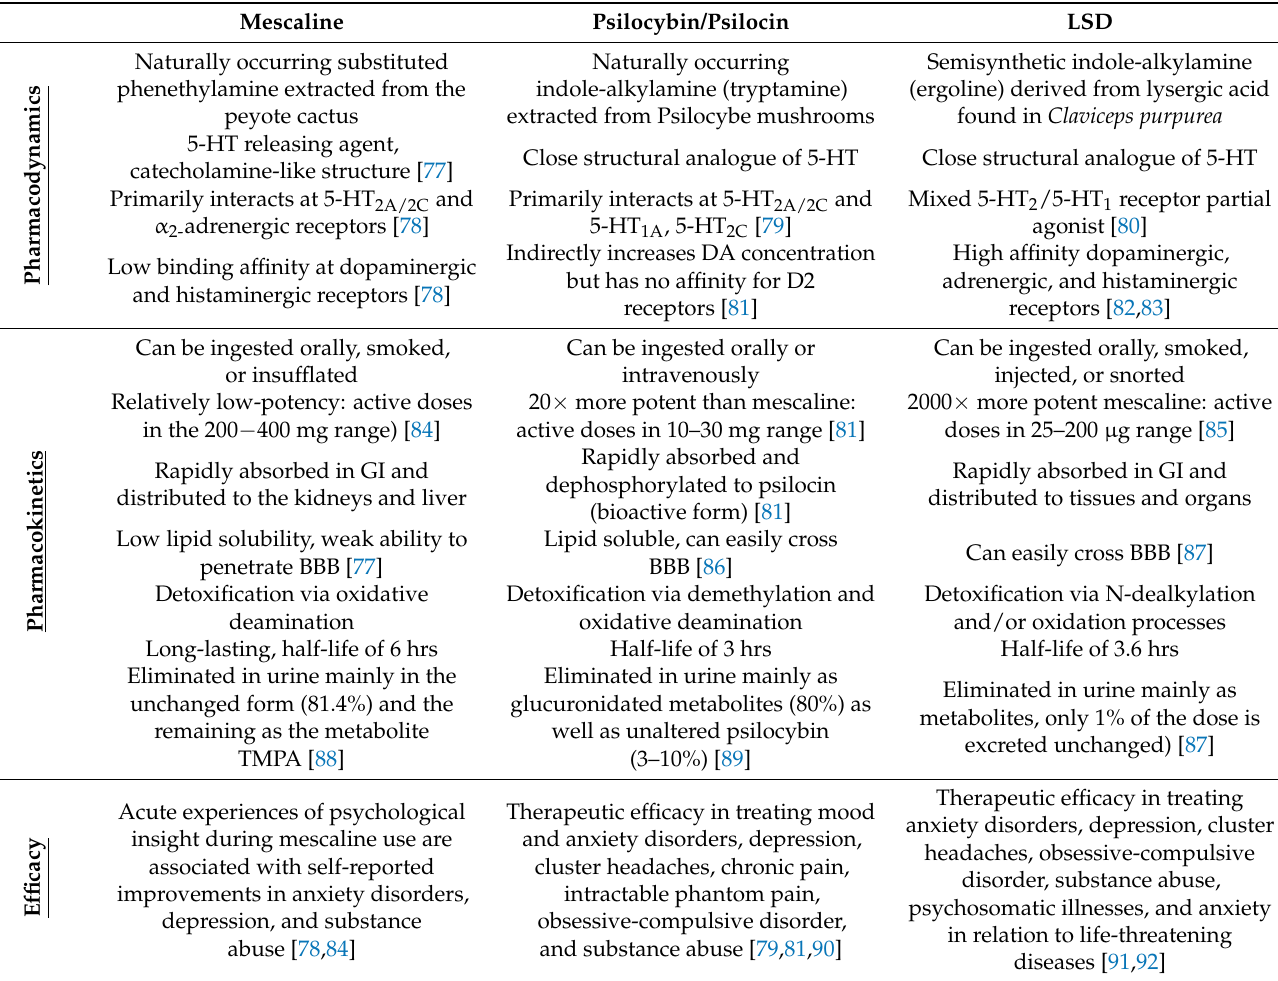
Table 2. Fungal biologics of therapeutic